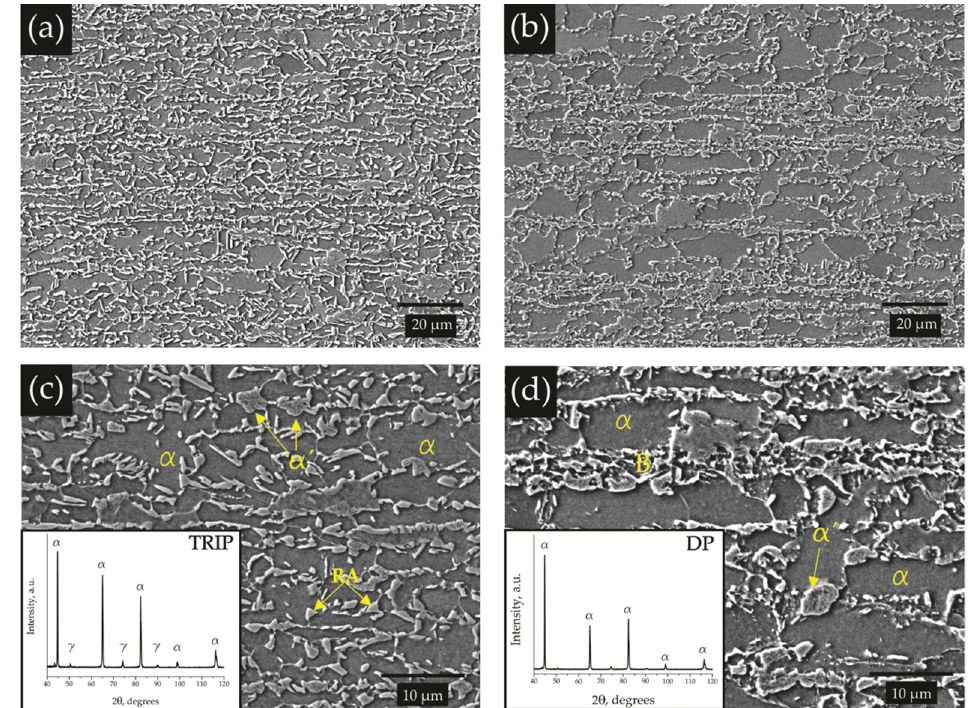
Figure 1. TRIP steel: ( a ) base metal microstructure, ( c ) TRIP steel phase distribution; DP steel: ( b ) base metal microstructure, ( d ) DP steel phase distribution. Table 2. Selected welding parameters for GMAW and LBW.